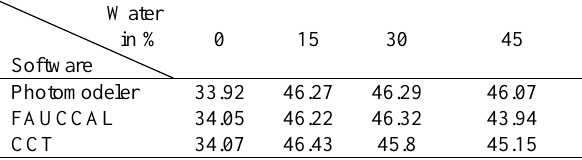
Table 1. Camera constant results from experiments with 0, 15, 30, and 45% of intervening water between the camera and the